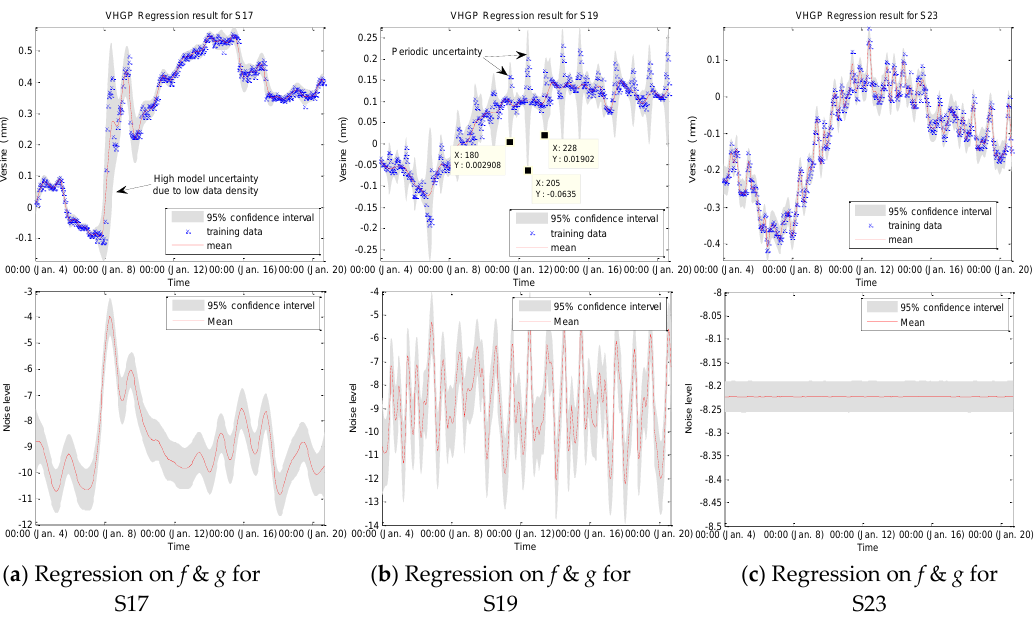
Figure 14. VHGP regression results on field data: ( a ) mean and log-noise distribution for S17; ( b ) mean and log-noise distribution for S19; and, ( c ) mean and log-noise distribution for S23.